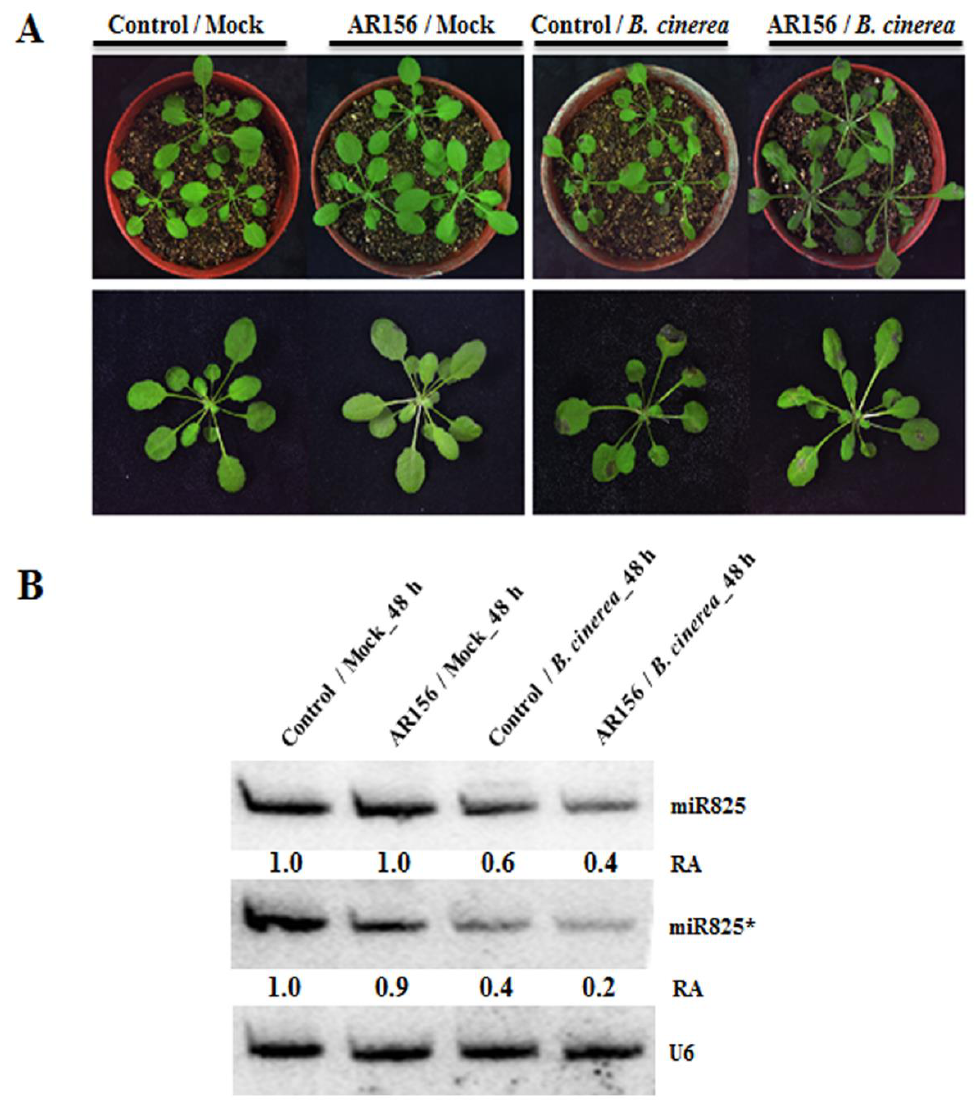
Figure 1. Theexpression level of miR825 and miR825* in Arabidopsis . Three-week-old Arabidopsis Col-0 plants were pretreated with AR156 at 5 × 10 8 CFU / mL or 0.85% NaCl (the control) as a root drench; at 7 days post-treatment (dpt), challenge inoculation was carried out by dropping 10 µ l of a B. cinerea B1301 spore suspension at 1 × 10 6 spores / mL or H 2 O (mock) on the midvein of each side of a leaf. ( A ) At 48 h post-inoculation (hpi), disease symptoms on leaves were observed and photos were taken. ( B ) The miR825 and miR825* expression in di ff erent treatments was detected by Northern blotting. Total RNA was extracted from leaves of Arabidopsis Col-0 plants in four treatments (control / mock, AR156 / mock, control / B. cinerea , and AR156 / B. cinerea ) at 48 hpi. RNA blots were probed with DNA oligonucleotides complementary to miR825 or miR825*. U6 served as a loading control. Relative abundance (RA) levels are indicated. The experiments were repeated three times, which yielded similar results.